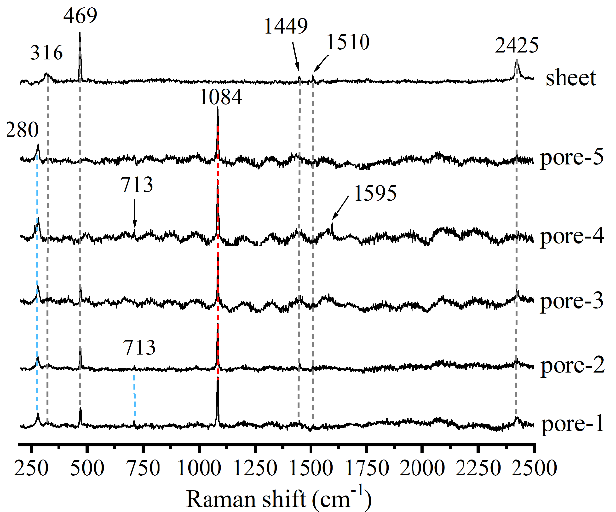
Figure 3. Raman spectra of hydration products in different pores (treated by water condition). By contrast, with 65% RH (Figure 4), the 828 and 894 cm − 1 peaks were the characteris- tic of Raman shifts of C 3 S [36,37]. Apart from the signals of unhydrated C 3 S and the sheet, the 1084 cm − 1 peak was prominent which was consistent with the results of Figure 3. The broad band at 551 cm − 1 was due to Si-O-Si stretching modes in Q 3 silicate tetrahedra [32]. The peak at 519 cm − 1 resulted from the O-Si-O bending mode in the C-S-H